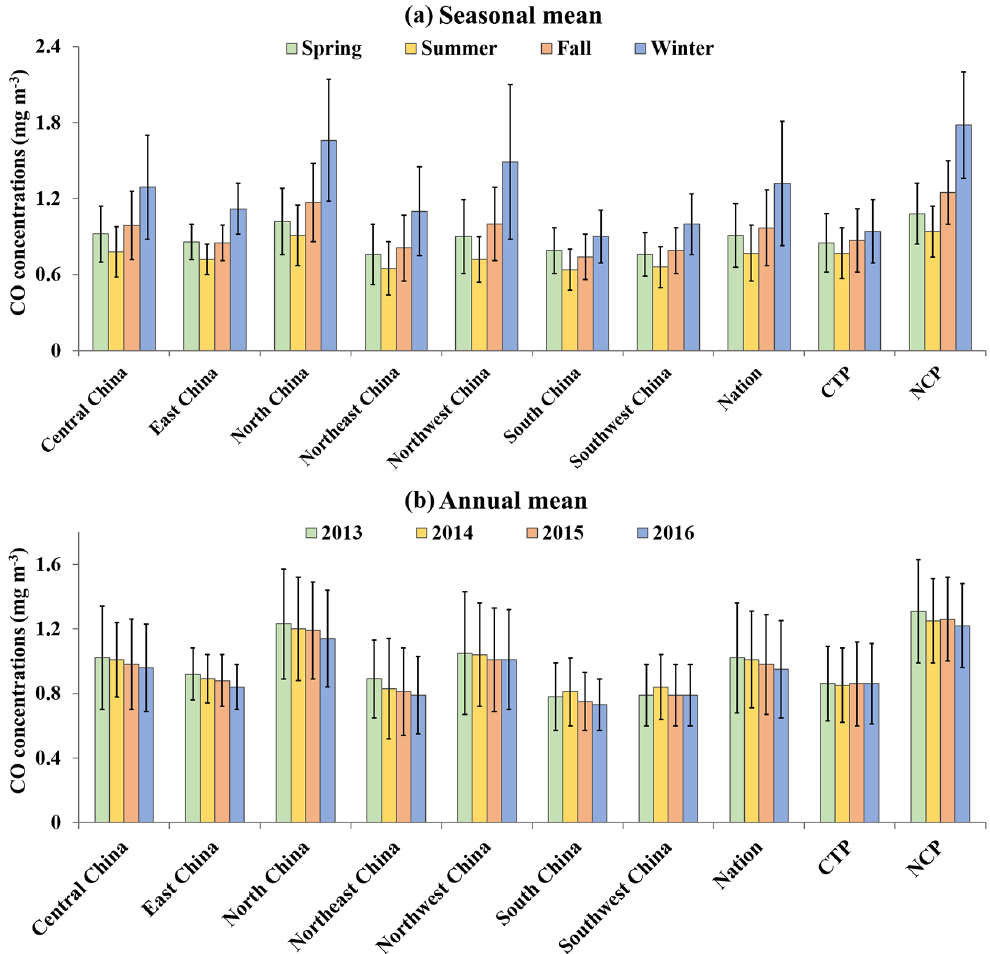
Figure 2. (a) Seasonal and (b) annual means of the population-weighted average ground-level CO concentrations (mgm − 3 ) during 2013– 2016 for China predicted by the RF–STK model. The error bars (standard deviations) stand for the spatial